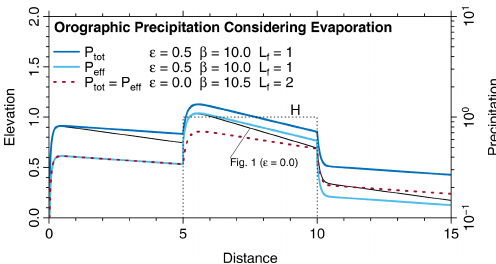
Figure 4. Effect of elevation-dependent evaporation on precipita-